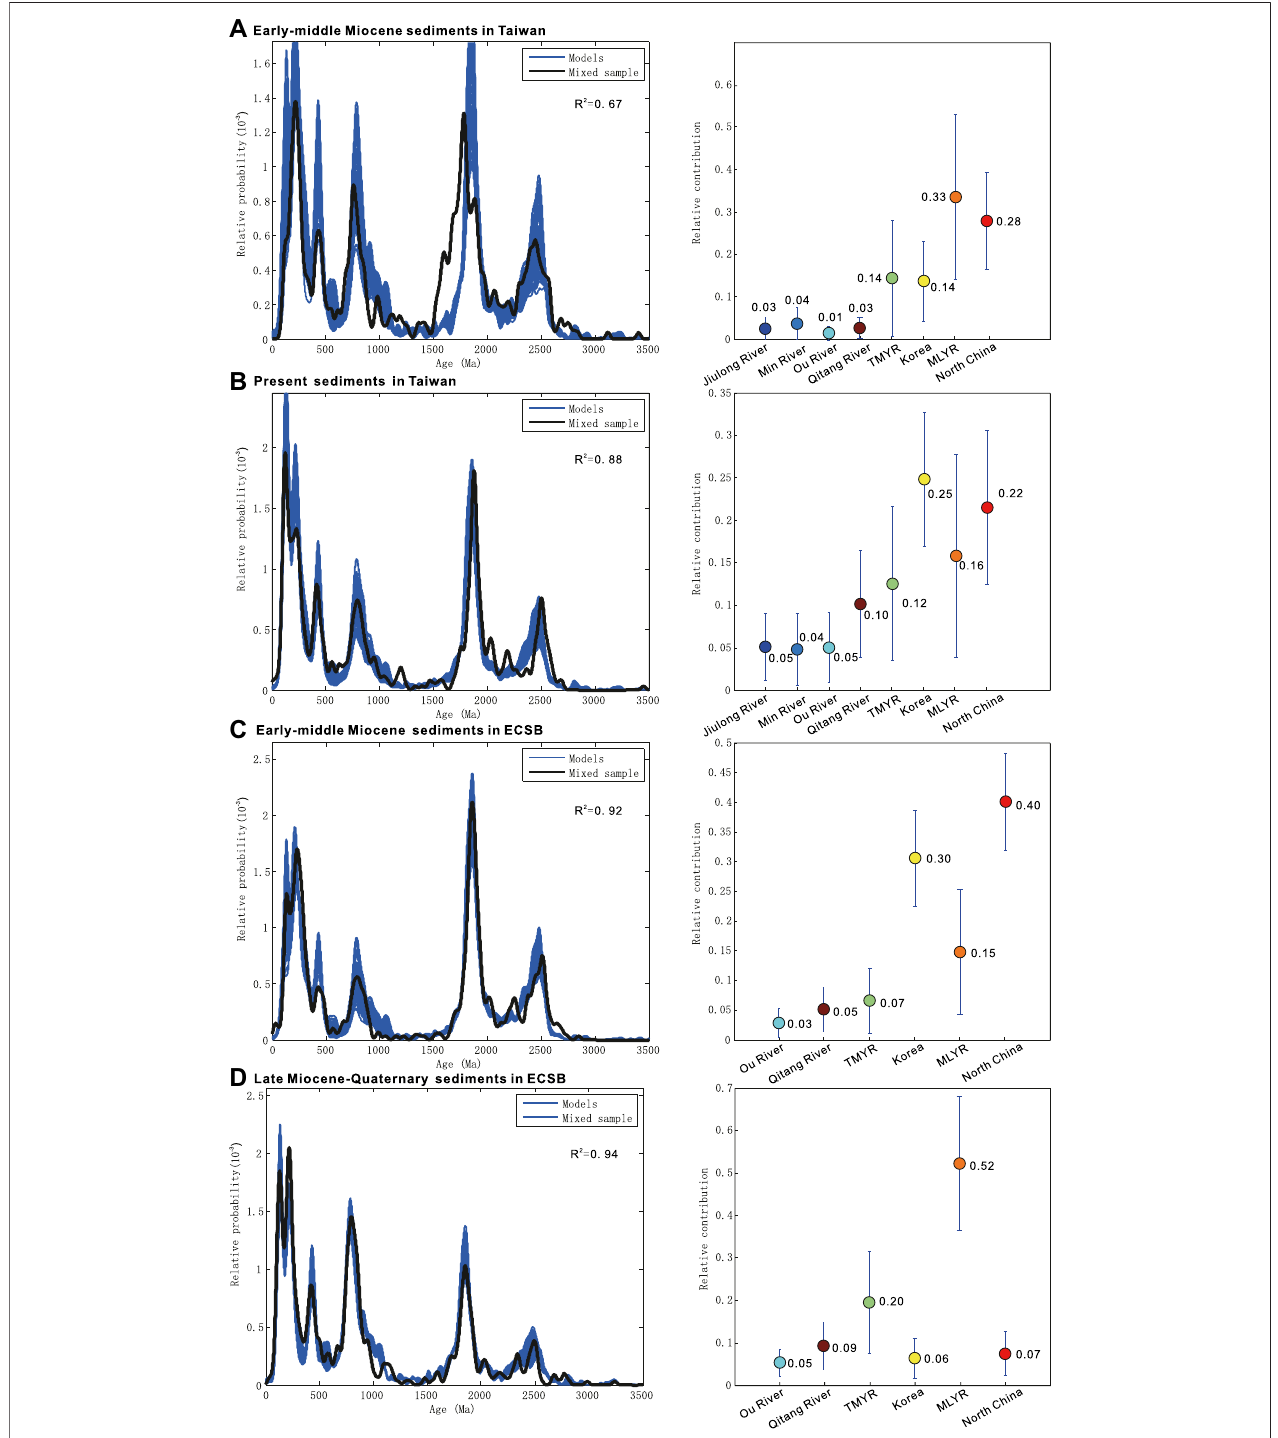
FIGURE 5 | The mixing modelling showing contribution of source areas for early-middle Miocene sandstones and present sediments from Taiwan, Miocene- Quaternary sandstone from ECSB. The modelling was generated by the Monte Carlo model (Sundell and Saylor, 2017). The fl uvial samples in the source areas were compiled to quantitatively determine the ultimate contributions from different sources. Note that the Min River and Jiulong River are not used in the modelling for ECSB. MLYR, middle and lower reaches of the Yangtze River trunk stream; TMYR, tributaries in the middle reaches of the Yangtze River.